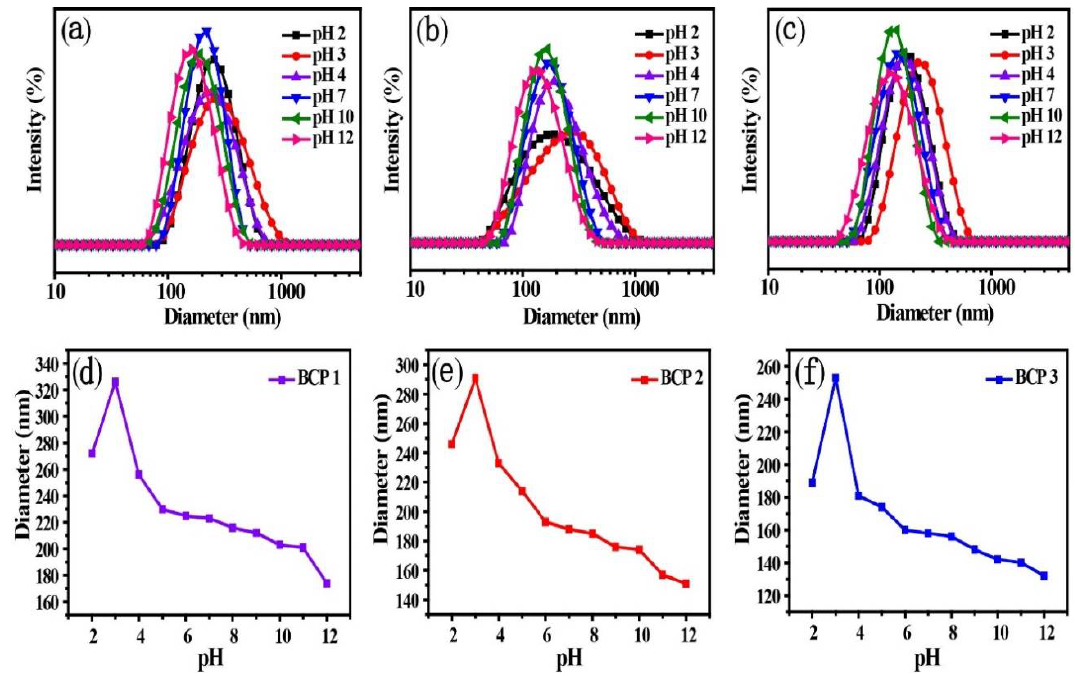
Figure 3. DLS plots of amphiphilic copolymer aggregates and schematic of the aggregate size variation of BCP1 ( a , d ), BCP2 ( b , e ) and BCP3 ( c , f ) under different pH values of aqueous solution.